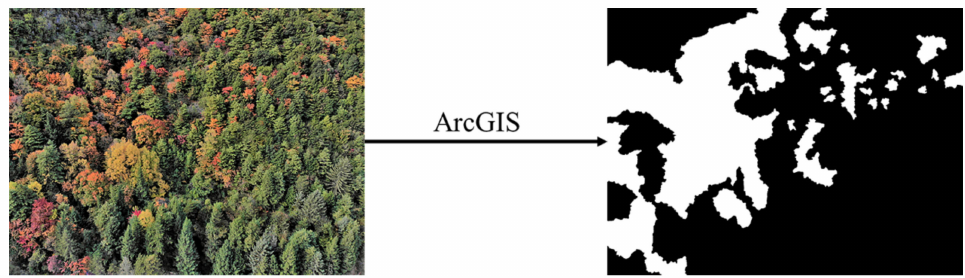
Figure 2. Diagram of the canopy gap boundary definition process. The left is the original picture of a plot; the right is the map of gaps after processing. A white patch represents a